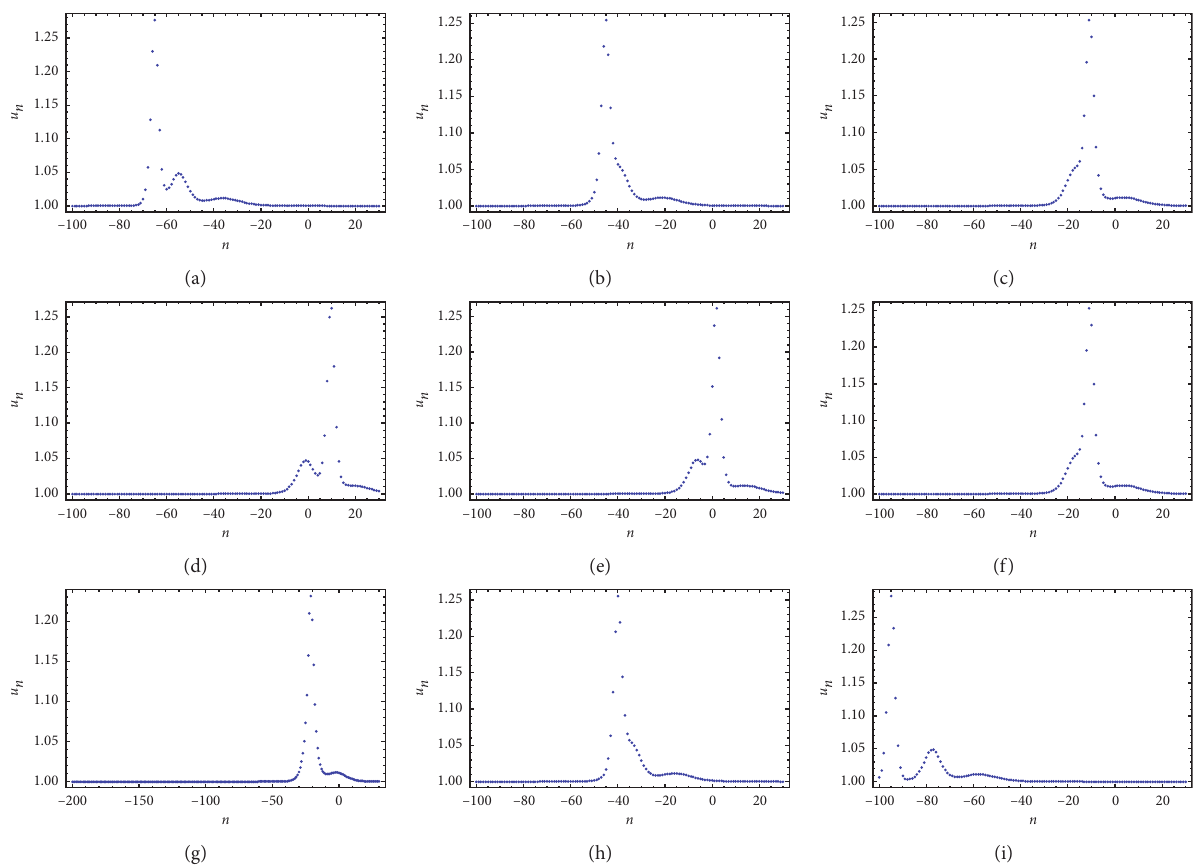
Figure 8: Dynamical evolution of the semidiscrete three-soliton solution determined by solution (53) with the parameters α � t 3 , α � sech 2 t , c ( 0 ) � 1, c ( 0 ) � 2, c ( 0 ) � − 3, z � 0 . 8, z � 0 . 9, and z � 0 . 6. (a) t � − 2.7. (b) t � − 2.5. (c) t � − 2. (d) t � − 1. (e) t � 0. α 2 3 1 2 3 1 2 3